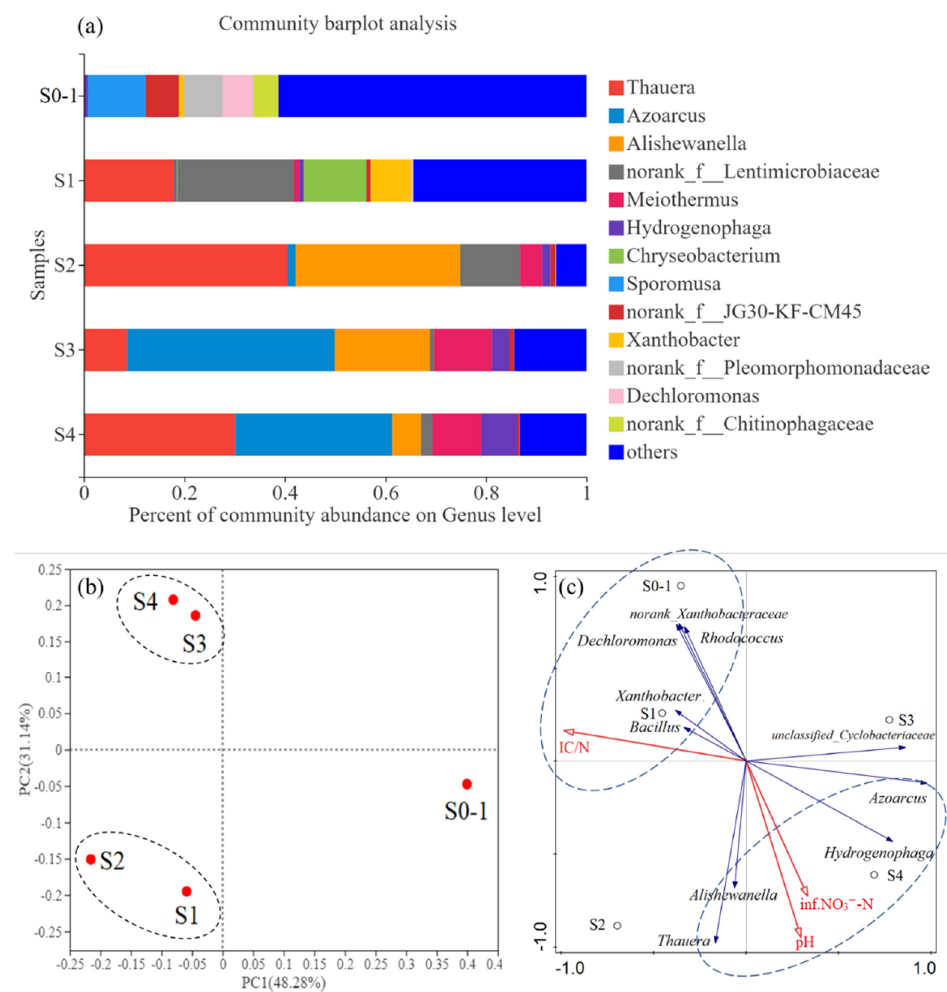
Figure 6. Distribution of the bacterial community at genus level (>5%) ( a ) and principal coordinates analysis of them during different stages of reactor operation ( b ), as well as the Redundancy analysis (RDA) map of the response of known denitrifiers to environmental factors ( c ).